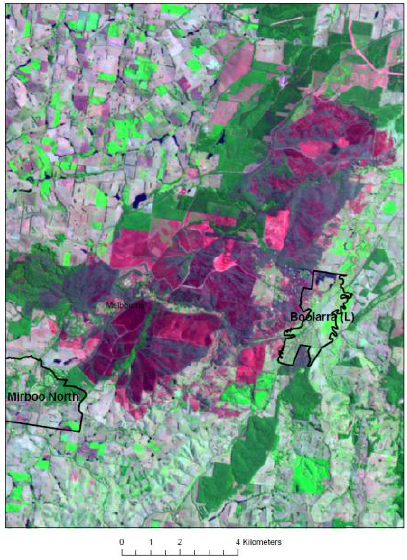
Figure 2. Delburn post-fire image acquired 02 Feb